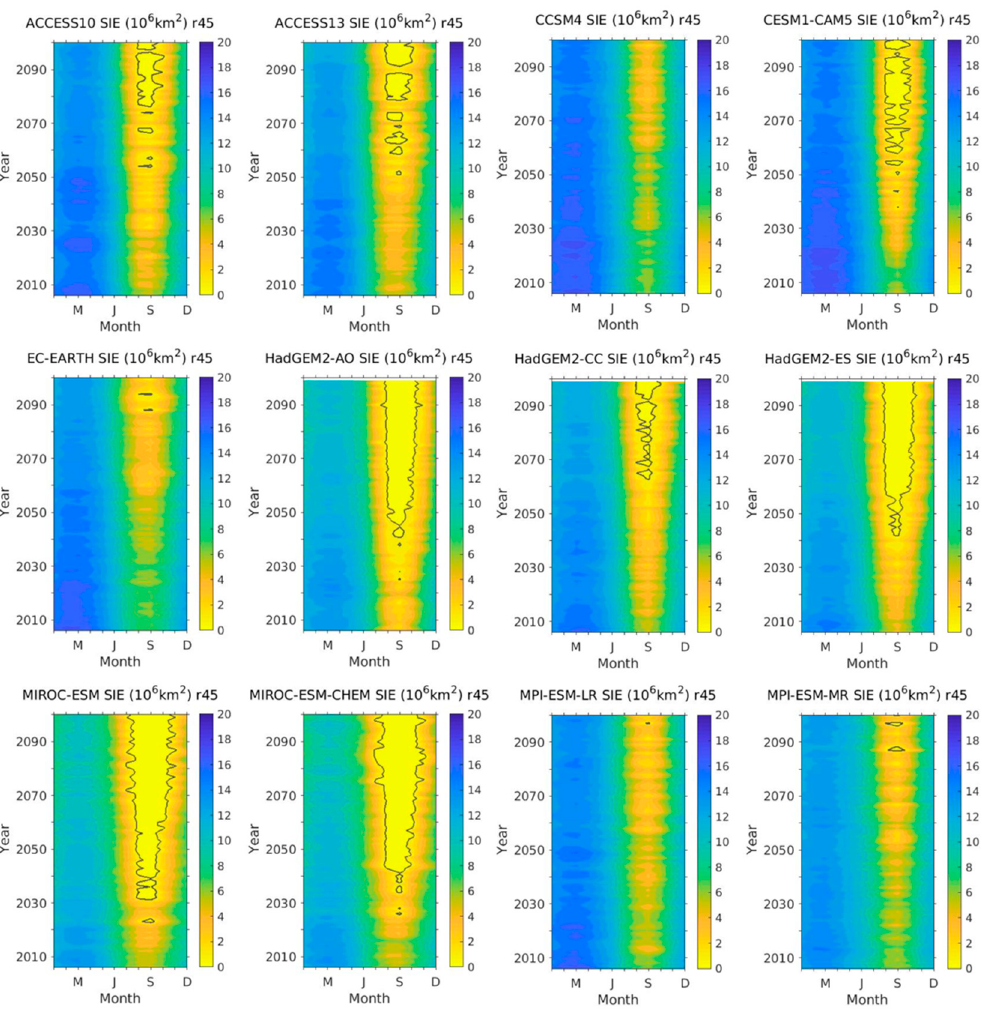
Figure 2. Same as Figure 1 except for a midrange emission scenario Representative Concentration Pathway 4.5 (RCP4.5) (r45). The dark gray contour lines denote the SIE value of one million square kilometers (i.e., 1 × 10 6 km 2 ).